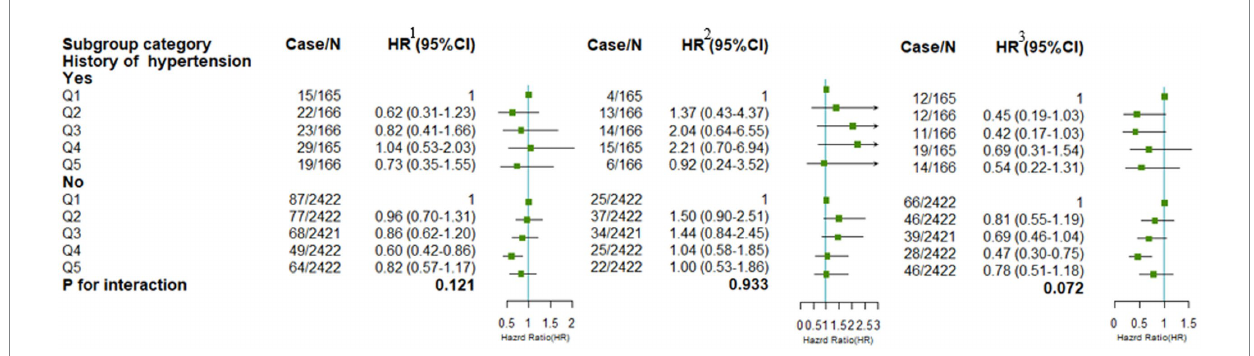
FIGURE 4 Stratified analyses by the history of hypertension at baseline of the association between breakfast energy intake and health outcomes. Adjustments included age, gender, urban or rural location, education level, income, physical activity, smoking status, alcohol intake, BMI, history of diabetes, total intake of energy, SFA, grains, vegetables, and dietary fiber, if not stratified. 1 refers to major cardiovascular events; 2 refers to myocardial infarction; 3 refers to new-onset